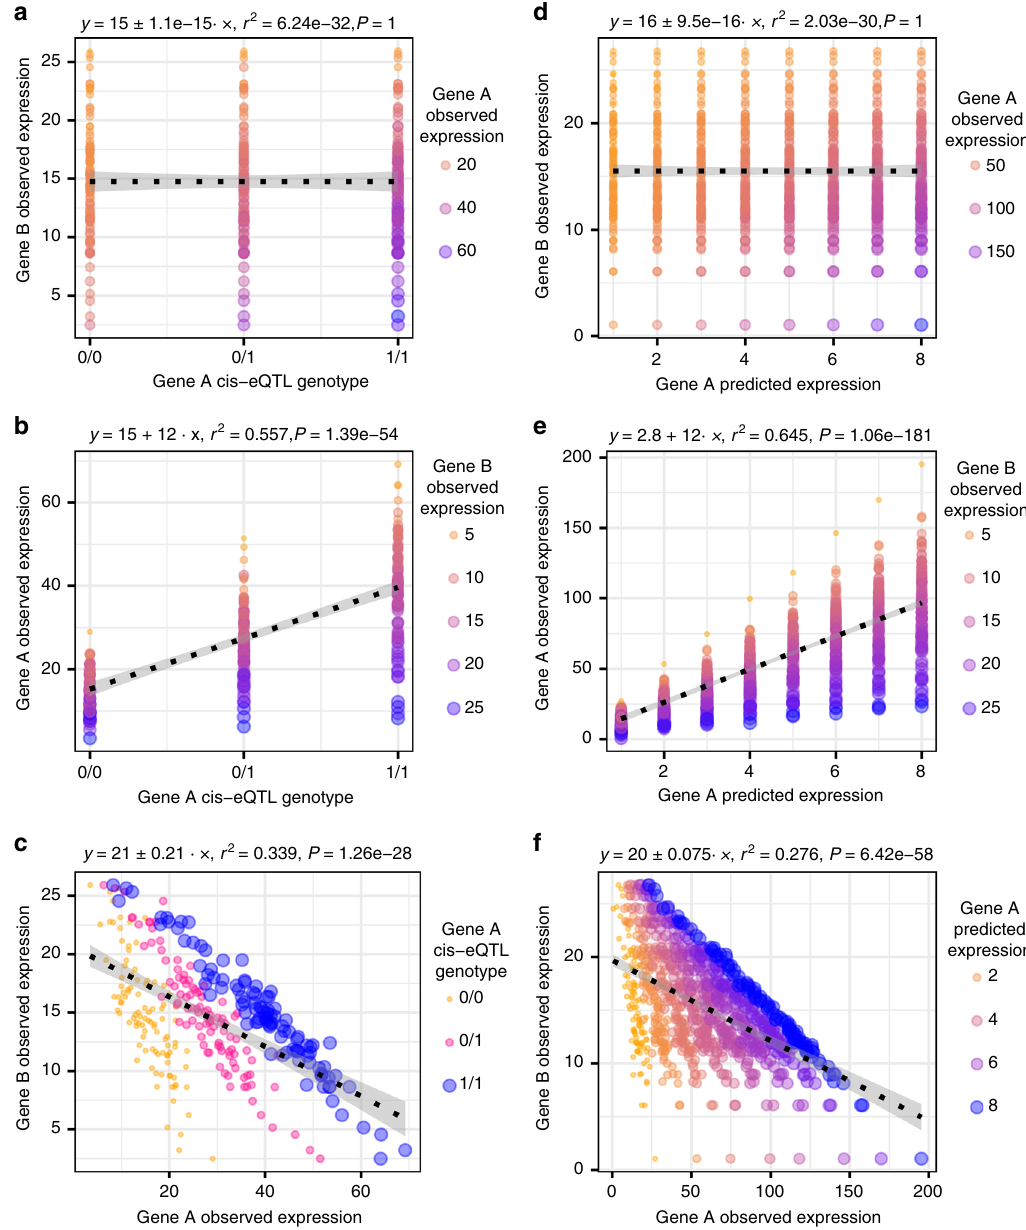
Fig. 3 Interactions can lead to genotype-dependent and regulatory variant-set-dependent variance in a gene ’ s expression levels. Simulated data illustrating that a gene A ’ s expression is only highest when the cis-eQTL genotype is 1/1 and the expression level of a distal gene (gene B ) is low. b Replotting the data in a on different axes illustrates how this interaction is associated with genotype-dependent variance in the expression of gene A , with greater variance in expression between individuals when the eQTL genotype is 1/1. c The interaction leads to genotype-dependent differences in the slope of the relationship between gene A and gene B ’ s expression levels. d – f The same principle extended to sets of cis-regulatory variants. P -values derived from Spearman ’ s rho